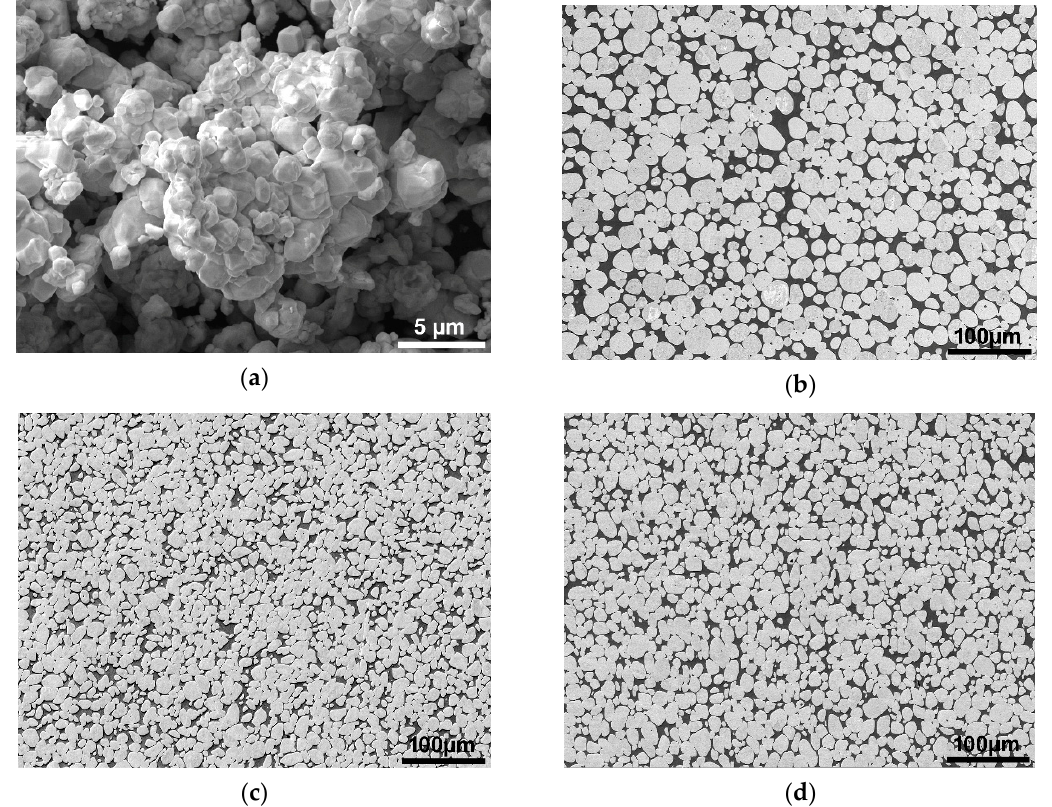
Figure 2. Original powder mixture ( a ); structures of investigated sample bars: W_0 ( b ); W_A ( c ); W_B ( d ).